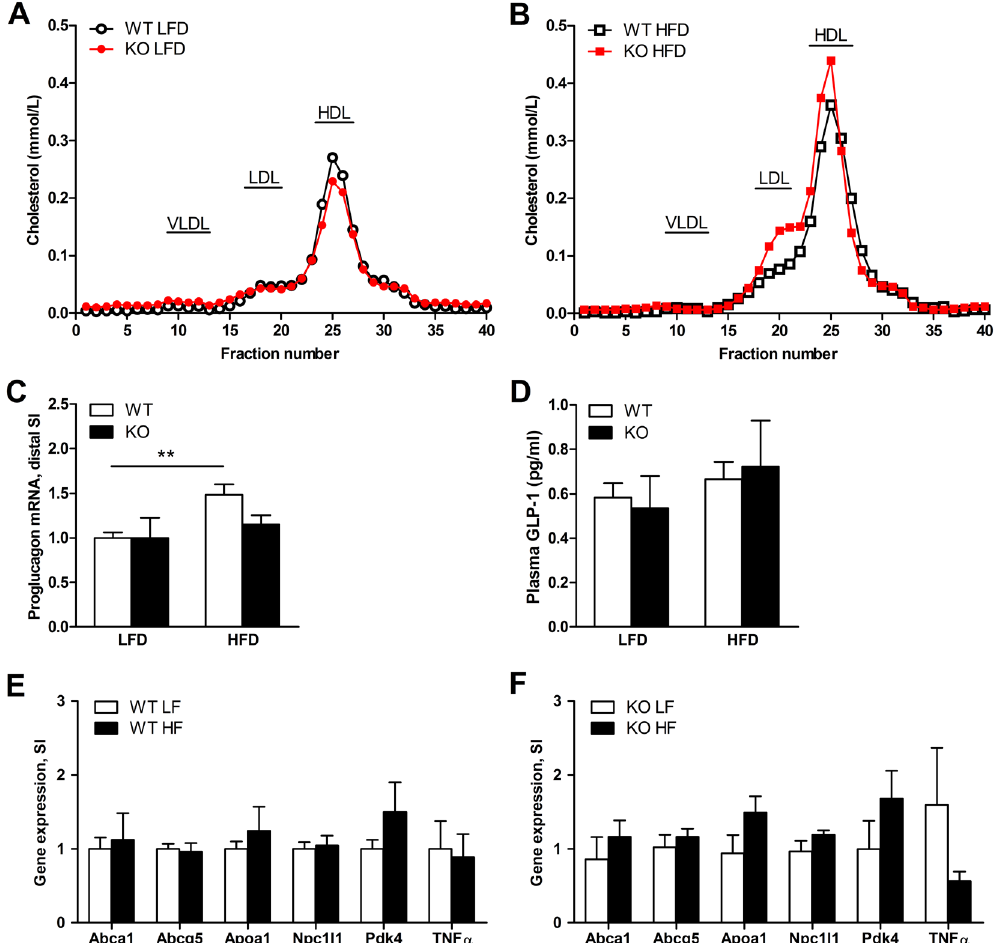
Figure 3. Effect of a HFD on plasma lipoprotein, plasma GLP1 and intestinal gene expression in PPAR δ IEC-KO and wild-type mice. ( A , B ) FPLC Lipoprotein cholesterol profiles of pooled plasma samples from PPAR δ IEC-KO mice and wild-type littermates fed a ( A ) LFD (n = 4–5) or ( B ) HFD (n = 10); Effect of a HFD challenge on ( C ) mRNA levels of proglucagon in distal small intestine (normalized to 36b4); ( D ) Plasma levels of Active GLP-1 (7–36) amide and GLP-1 (7–37) in wild-type and PPAR δ IEC-KO mice fed a LFD (n = 4–8) or HFD (n = 10); ( E , F ) mRNA levels of genes involved in lipoprotein metabolism and inflammation in the mucosa of the distal small intestine of ( E ) wild-type and ( F ) PPAR δ IEC-KO mice (normalized to